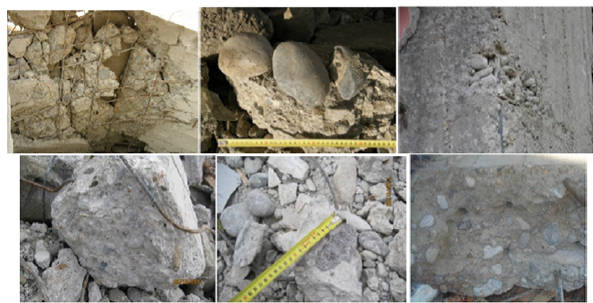
Figure 27. Concrete and aggregate samples in a single-story rein- forced concrete building that collapsed in the Van organized indus- trial site (20) and a concrete cross section displayed in the wreckage (Kizilkanat et al.,